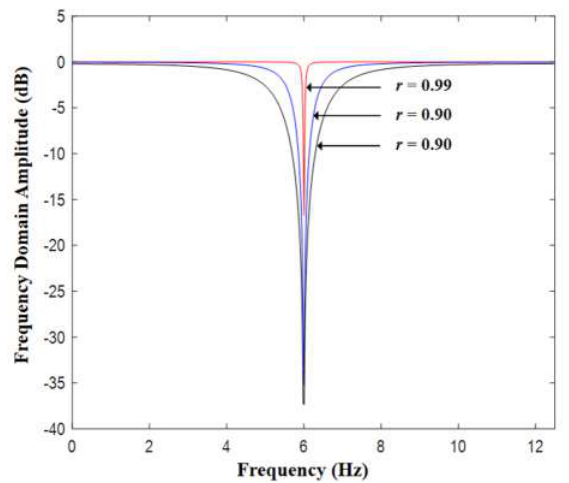
Figure 5. Frequency domain amplitude response of a notch filter.